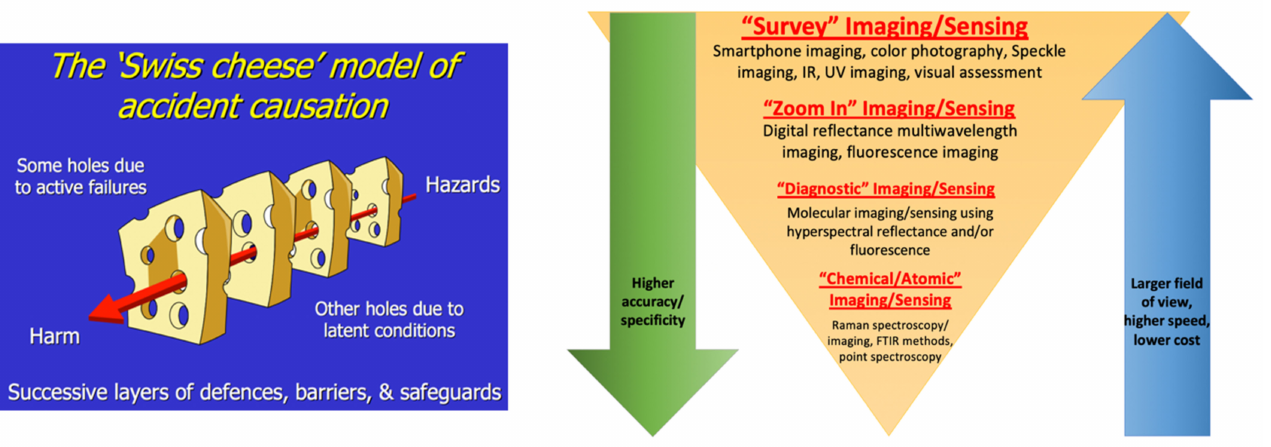
Figure 28. Risk (disease/problem non-detection) mitigation by “stacked, funneled” multimode